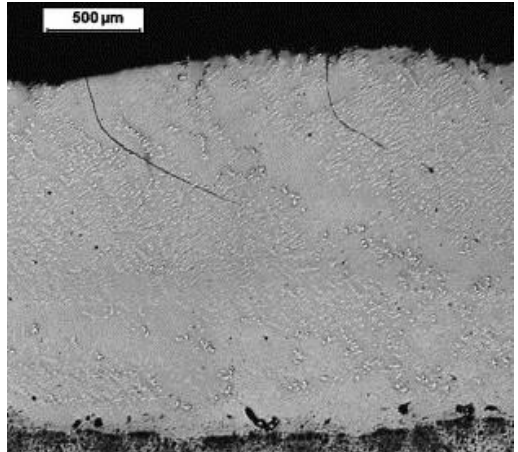
Figure 3. Cross sectional micrograph showing cracks in a laser cladded NiCrBSi layer [64]. Reprinted with permission from [64]. © 2005 Elsevier.